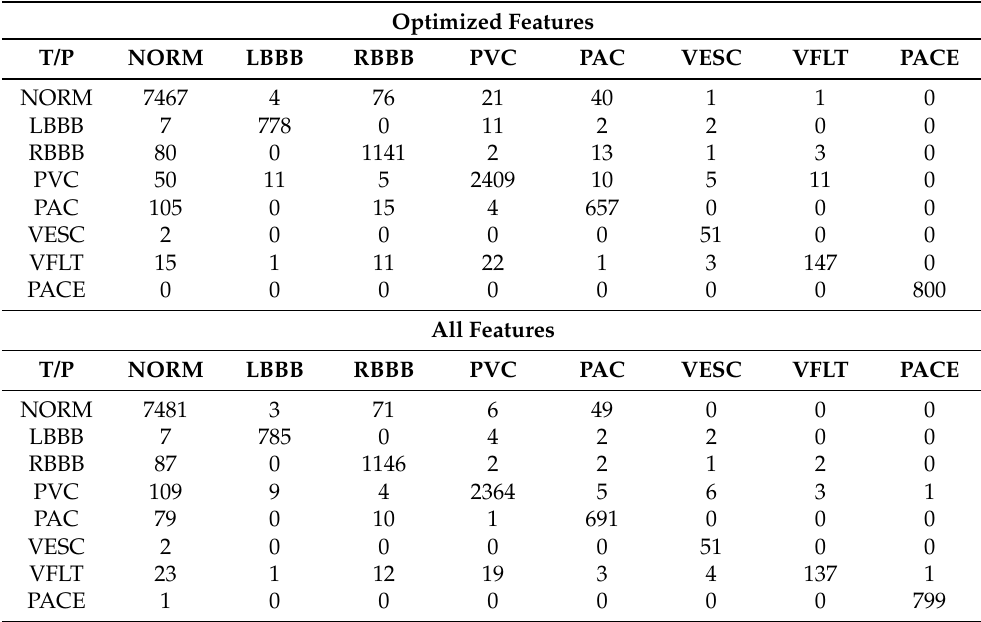
Figure 6. Selected feature scan after DE with all beat classes ( a ), feature points on 1 representative beat ( b ). Table 4. Confusion matrices for testing subset with Optimized and All features with fit = MCC for 1 normal and 7 arrhythmia